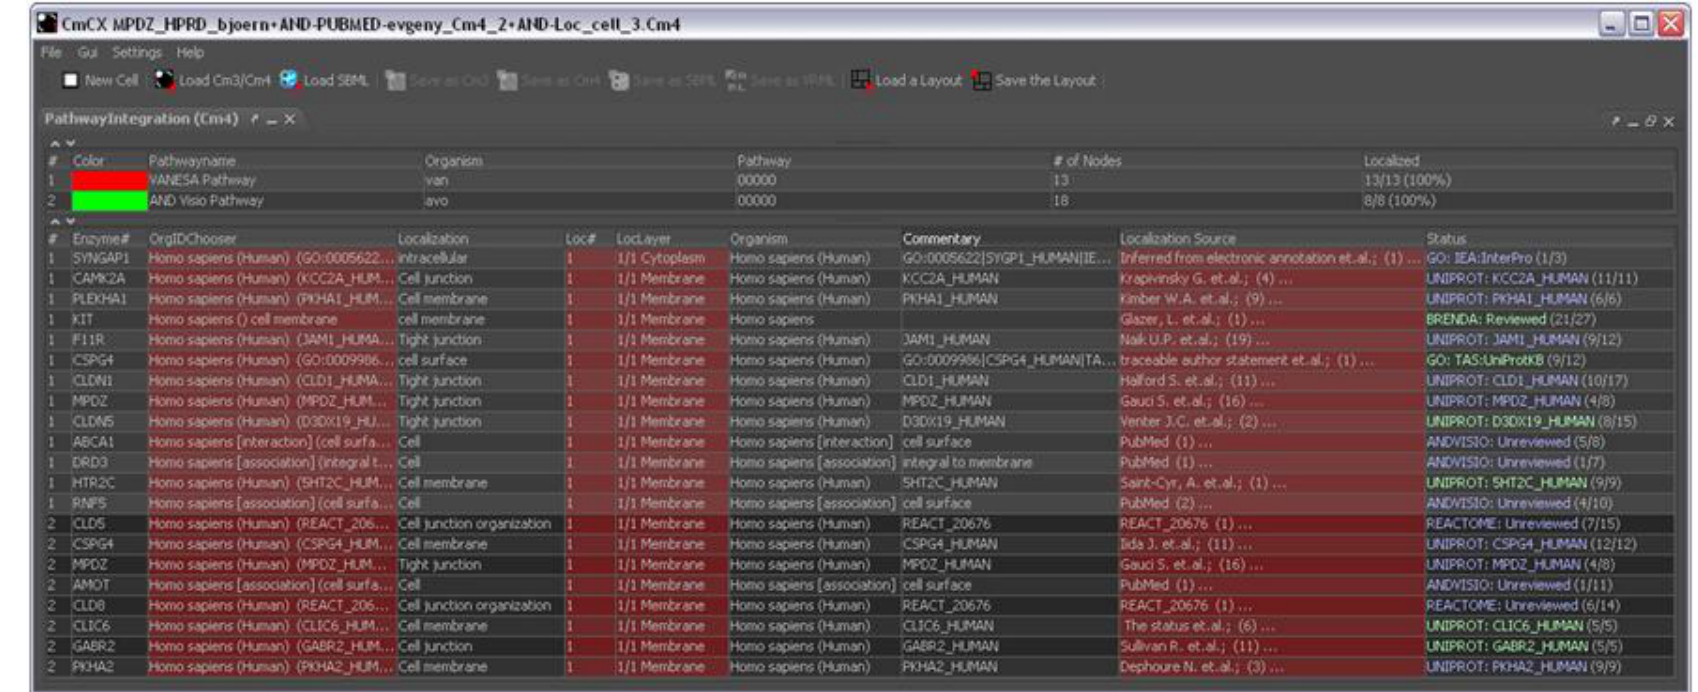
Figure 7: The combined localization results for the VANESA (#1) and the ANDVisio (#2) pathway. The VANESA Pathway includes the localization of the MPDZ interacting protein network (Fig. 1) using CmPI including results from ANDVisio: Five proteins could be localized to the tight/cell junction (including MPDZ), seven proteins to the cell membrane, one protein only to the cytoplasm